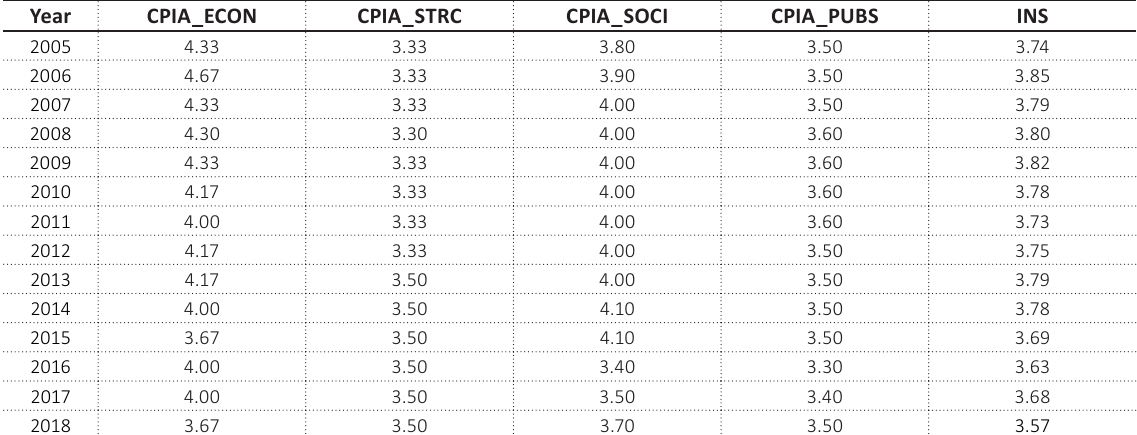
Source: Authors’ elaboration based on data of the World